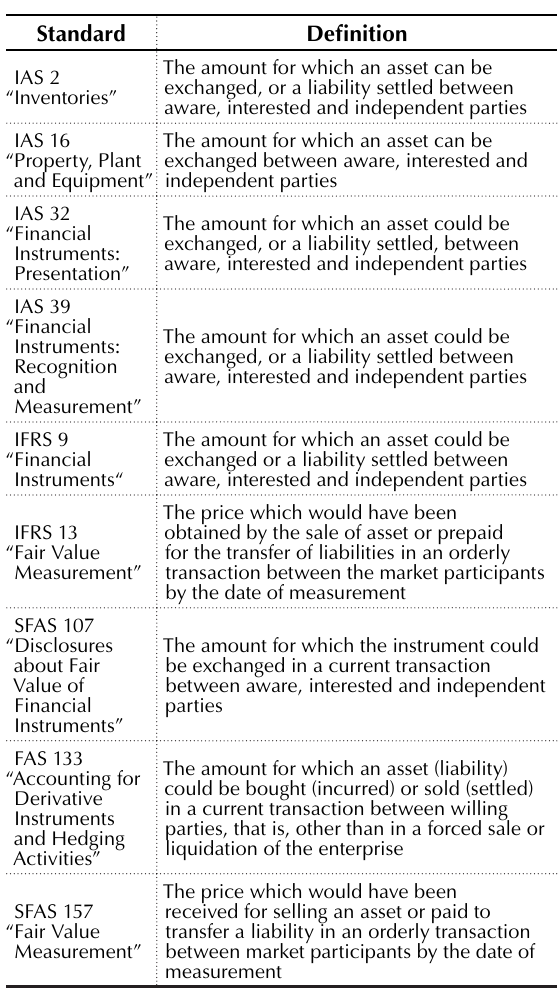
Table 2. Definition of the concept “fair value” according to the International